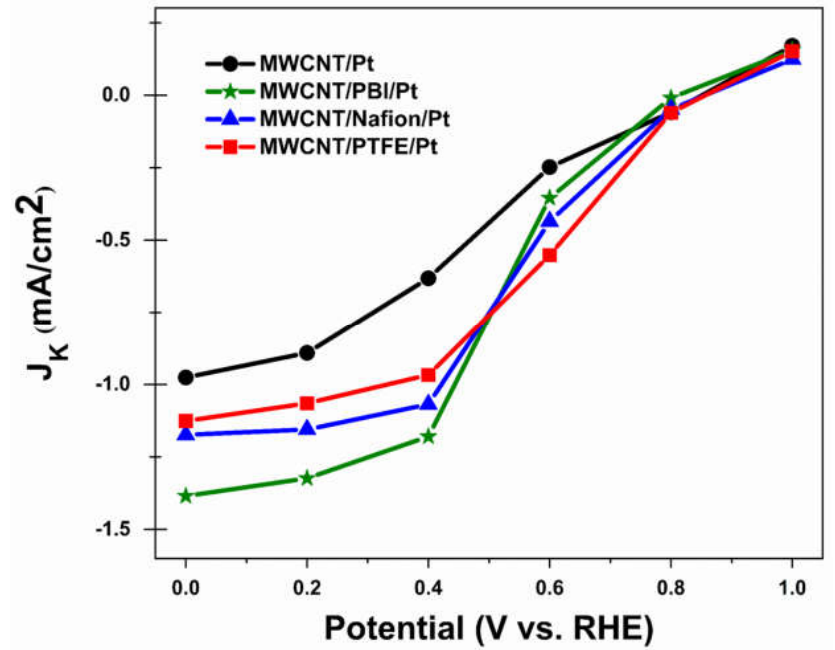
Figure 7. The kinetic limiting current density (Jk) of various electrocatalysts at different potentials.